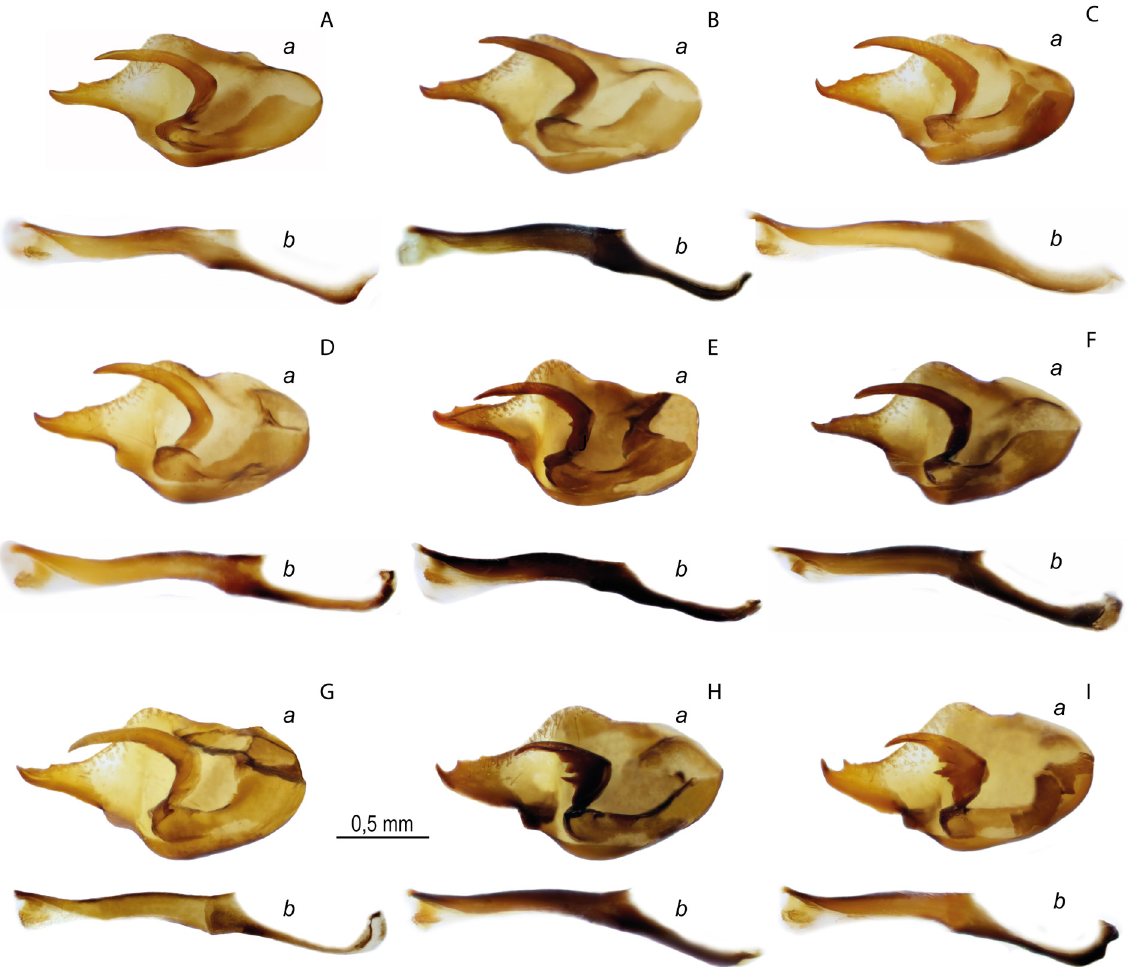
Fig. 3. Male genitalia (a = valva; b = aedeagus). A–G. Melitaea mimetica Higgins, 1940. H–I . M.